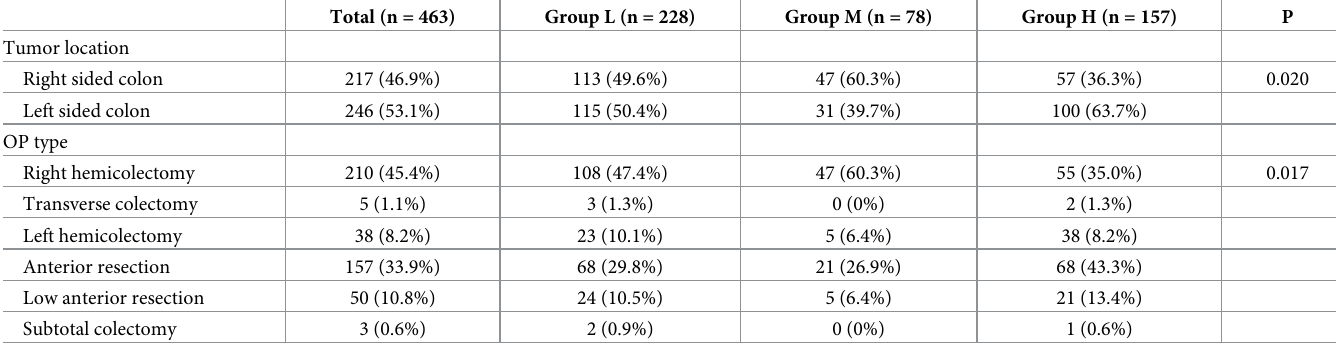
Table 3. Perioperative outcomes.